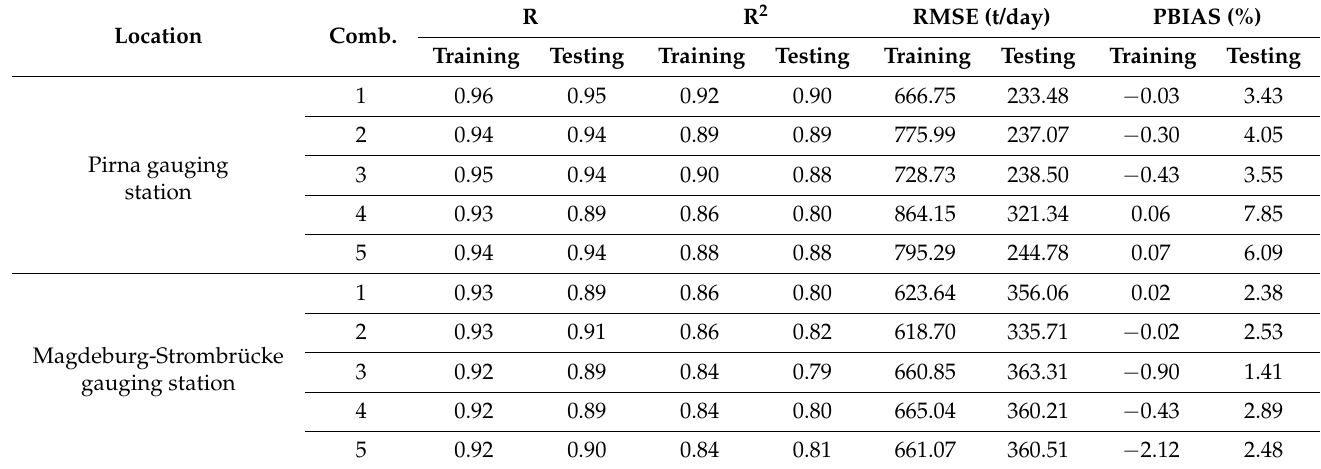
Table 7. The performance evaluation of the different ANN models.